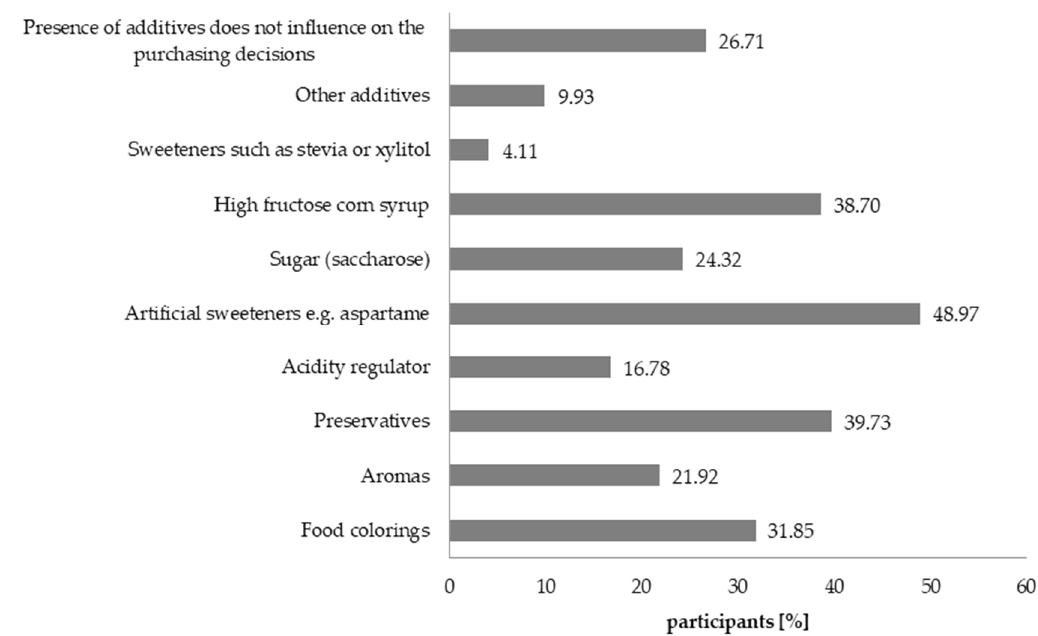
Figure 9. Ingredients of DSs which, when found in the composition of the product for children, may result in respondents deciding not to purchase such product. Values do not add up to 100%, due to the fact that more than one answer was allowed.